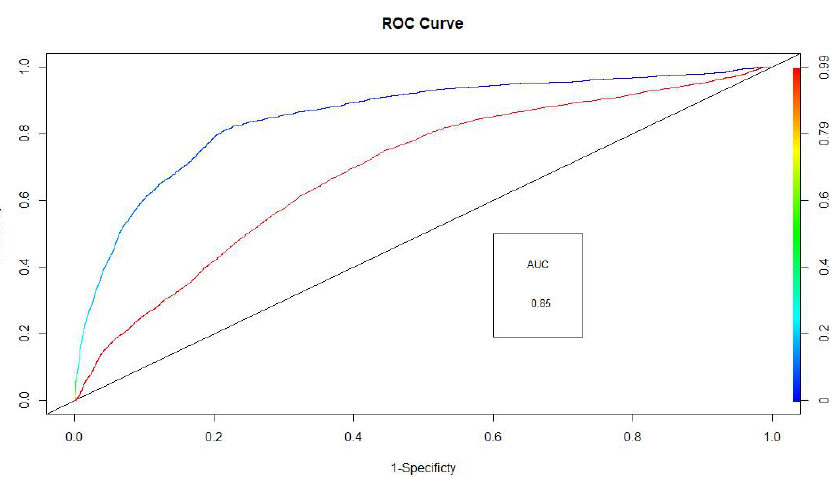
Figure 5. The graph depicts the ROC curve for the final fin whale model. The blue-coloured line depicts a better fit with an AUC = 0.85 than the red line, which represents the model with only shipping noise as an explanatory variable with a much lower AUC = 0.68. The diagonal black line indicates the chance model shows no discrimination with AUC = 0.5.